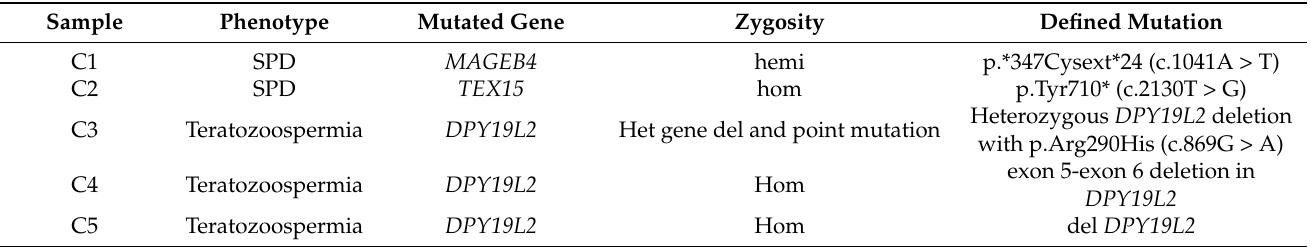
Table 2. Control samples: phenotype, zygosity, and mutation information. SPD: Sperm production defect, hom: homozy- gous, het: heterozygous, hemi: hemizygous.